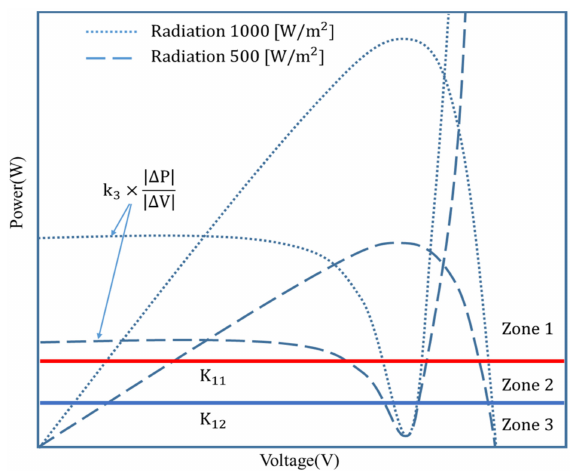
Figure 8. Changing value (C v ) and Zones 1~3 in the P-V curve.